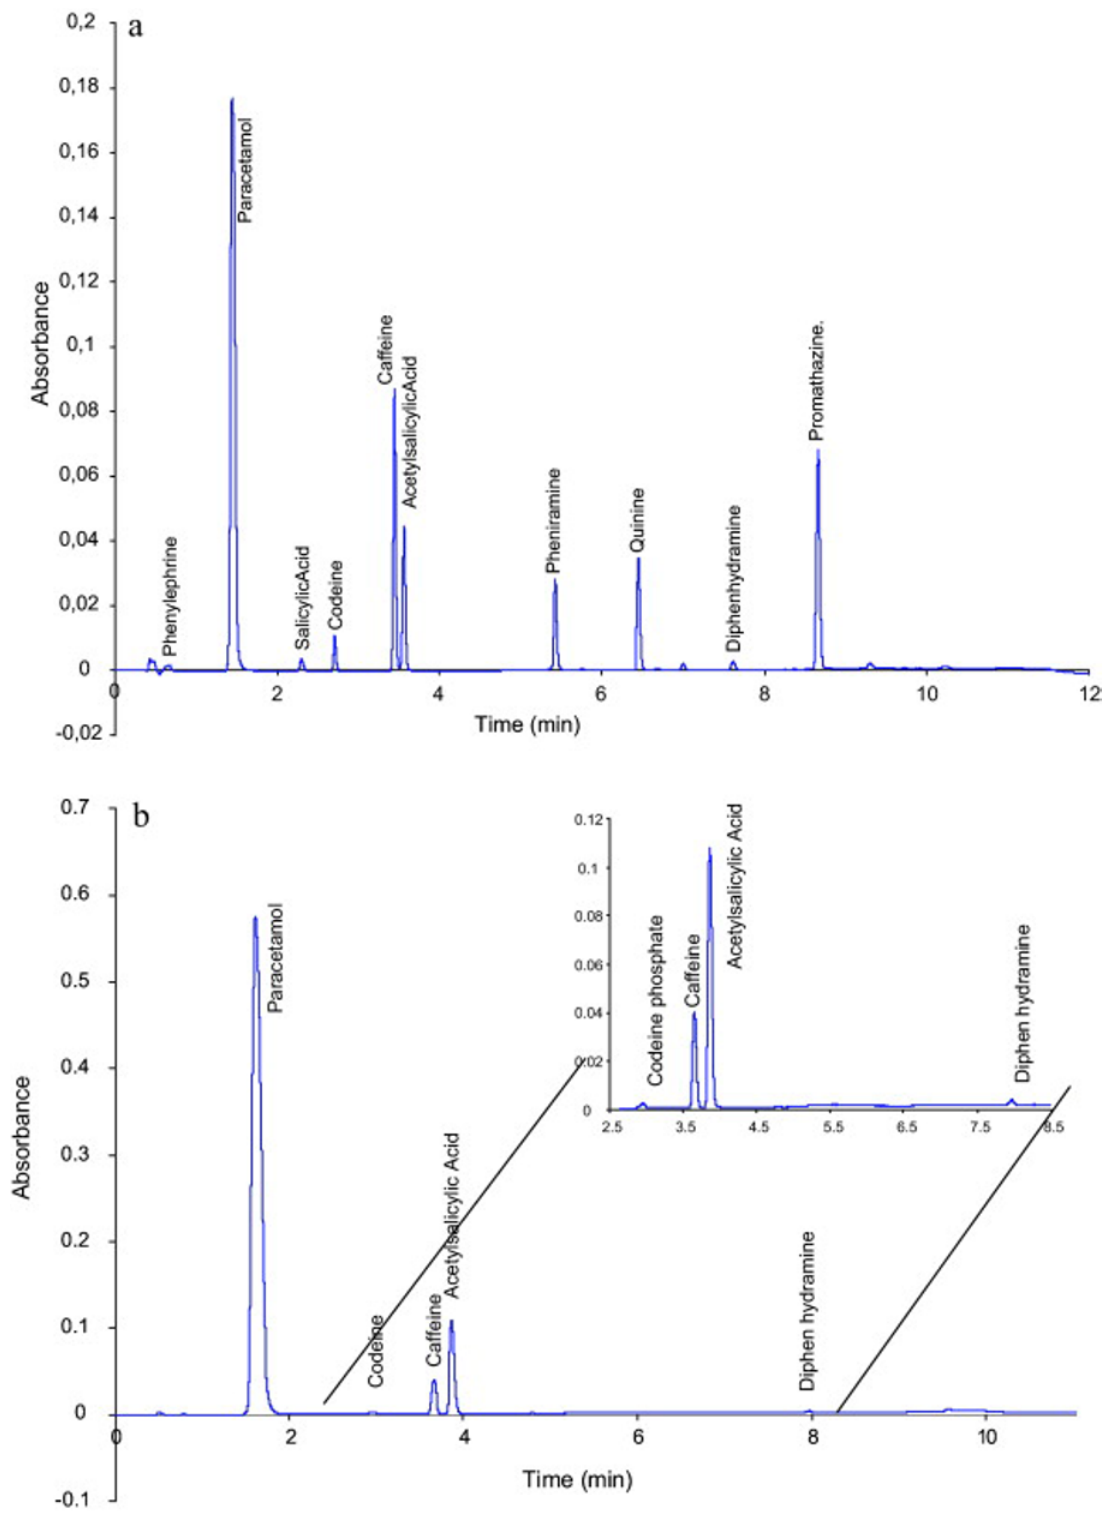
Figure 11. Chromatograms of HPLC separations of pharmaceutical preparations. HPLC was performed on an Acquity UPLC TM system. The gradient was performed on Acquity BEH C18 column, starts at 95% ammonium acetate buffer pH 4 and 5% methanol. The initial conditions are kept for 1 min, before going to a plateau of 50% buffer and 50% methanol in 9 min